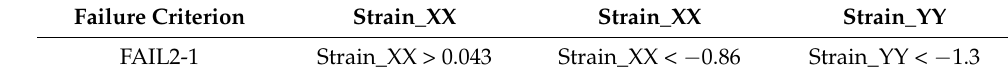
Table 3. Failure criterion considering tension strain and compression strain.